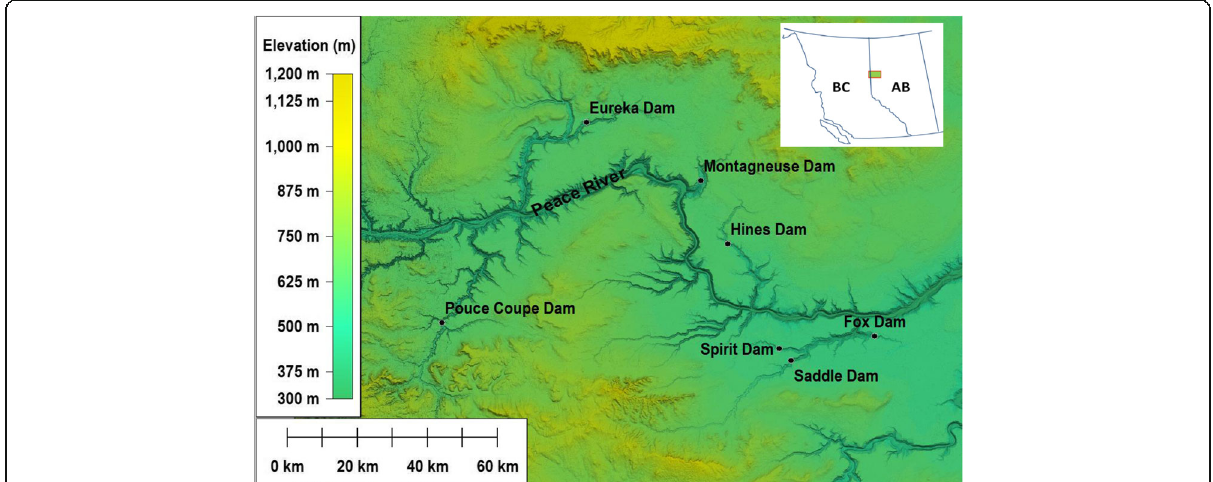
Fig. 1 Locations of the landslide dams. The regional topography was generated using digital topographic data from Natural Resources Canada (licenced under the Open Government Licence – Canada). The Peace River region is a broad, gently sloping plain which is deeply dissected by Holocene streams. The inset map shows the general study location (green box) in relation to the boundaries of the provinces of Alberta and British Columbia,